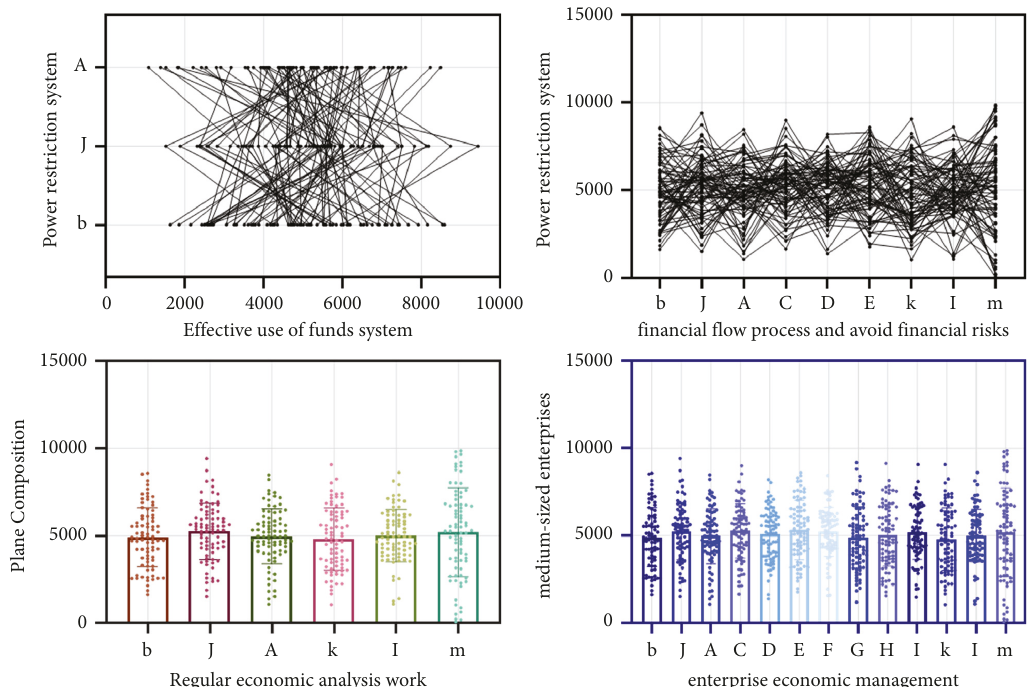
Figure 4: The application effect of enterprise refined economic management